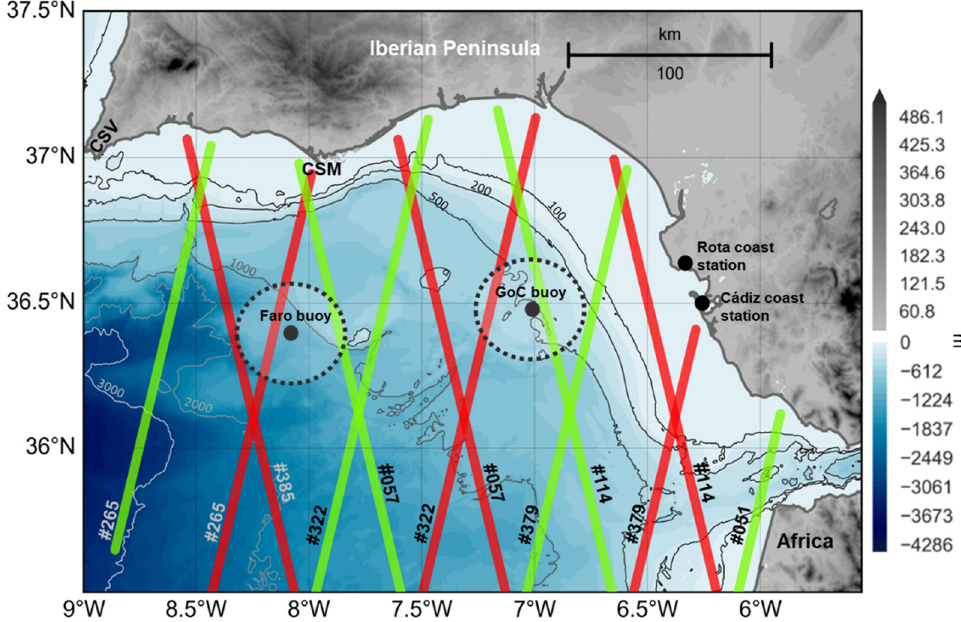
Figure 1. Study area (Gulf of Cádiz, southwestern coast of the Iberian Peninsula) along with the spatial distribution of the data sources used in this work and some geographical features: S3A tracks (red line), S3B tracks (green line), location of the moored (GoC buoy and Faro buoy) along with the 25 km radius area used to select S3A/B data for its validation (dotted contoured area), location of the land-based meteorological stations from the Spanish Meteorological Office (Cádiz coast station and Rota coast station), Cape Santa Maria (CSM), and Cape San Vicente (CSV).